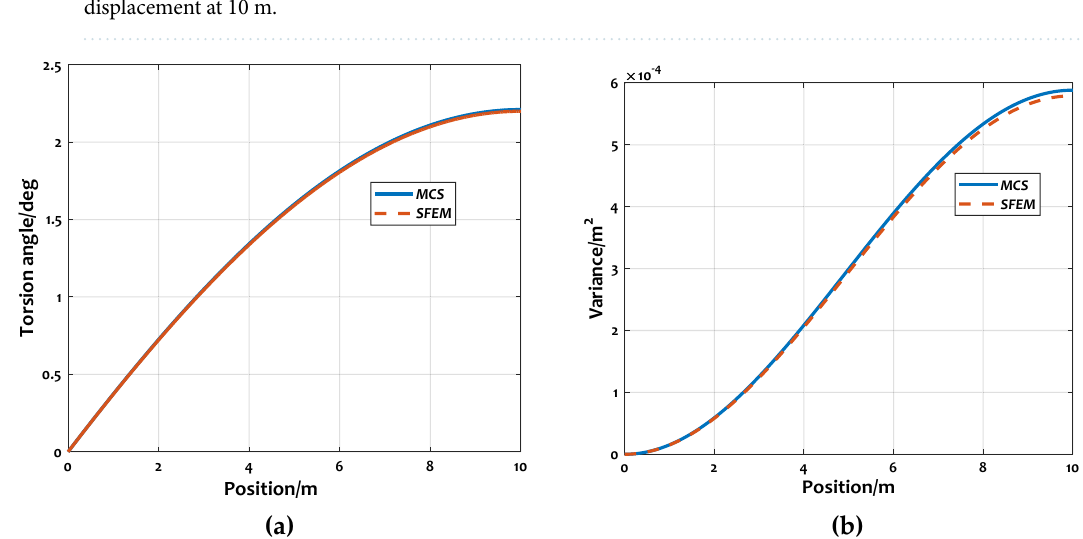
Figure 8. Comparison of statistical characteristics of wing torsion angle: ( a ) torsion angle expectations; ( b ) torsion angle